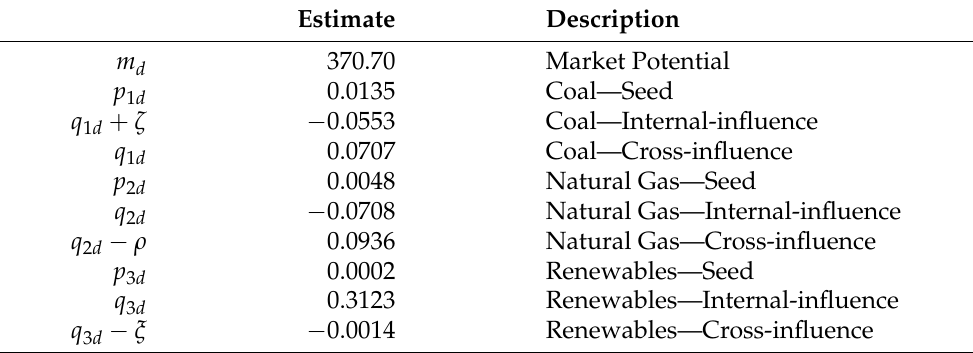
Table 3. UCTT model parameter estimates (double-competition phase) and their